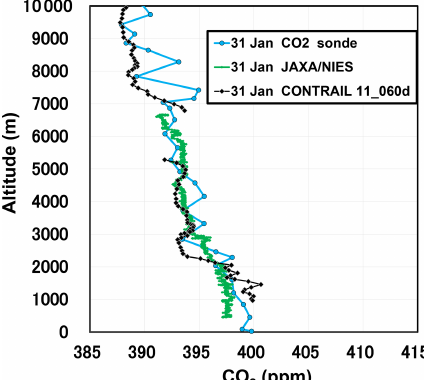
Figure 6. Flight paths of the CO 2 sonde observations launched at Moriya on 31 January (blue solid line) and 3 February (red solid line) 2011, the CONTRAIL 11_060d data on 31 January 2011 (black solid line) and 11_062d data on 2 February 2011 (black dashed line) from Hong Kong to Narita, and the NIES/JAXA char- tered aircraft experiment on 31 January (green solid line) and 3 February (purple dotted line). The altitudes of the flight paths are also indicated.